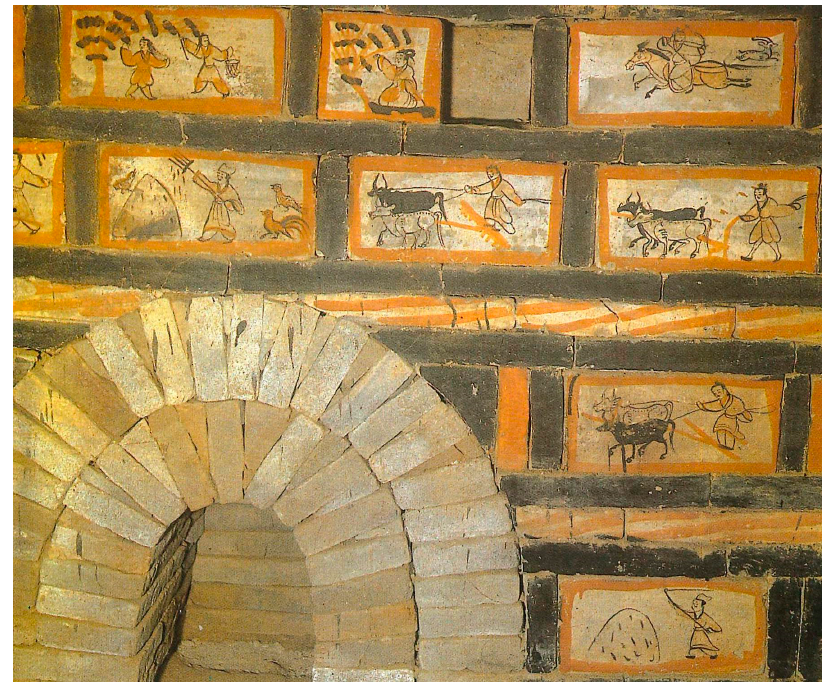
Figure 3. East wall of front chamber, Xincheng M5, carved and painted brick, Wei-Jin period (220–317). (Gansusheng Bowuguan et al. 1985, color pl. 1).